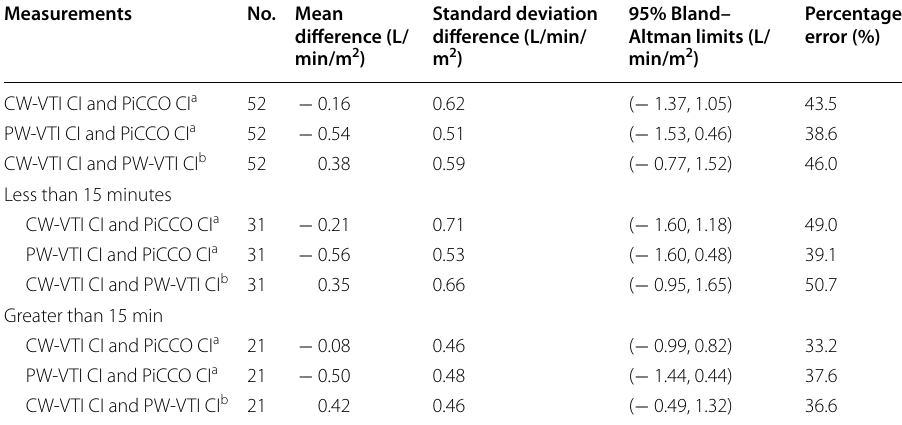
Table 3 Primary analysis and subgroup analysis by time, including mean differences between measurements, the standard deviation of the differences, the 95% Bland–Altman limits of agreement and percentage